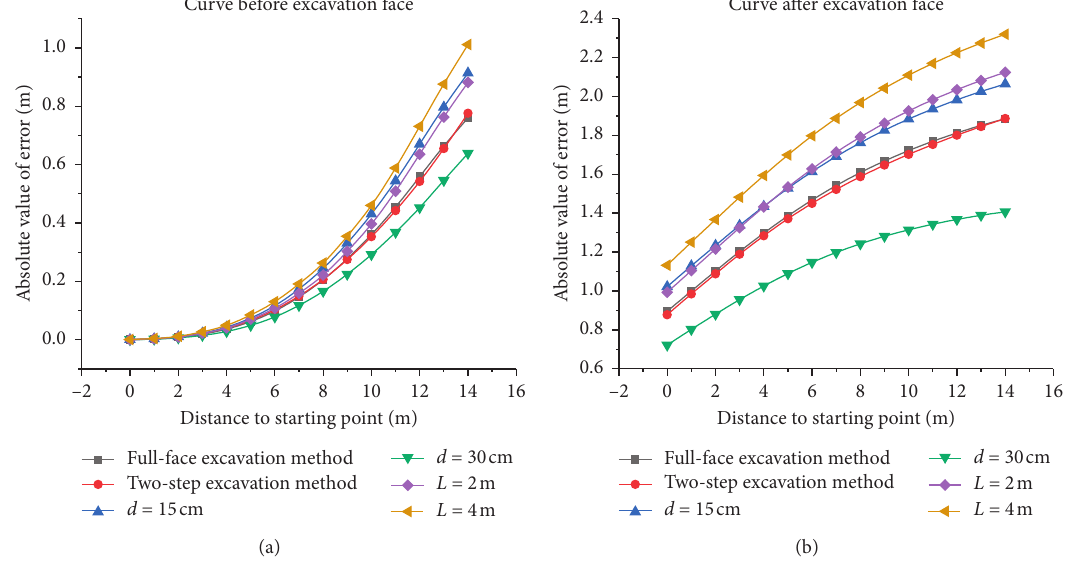
Figure 8: Error fitting of horizontal